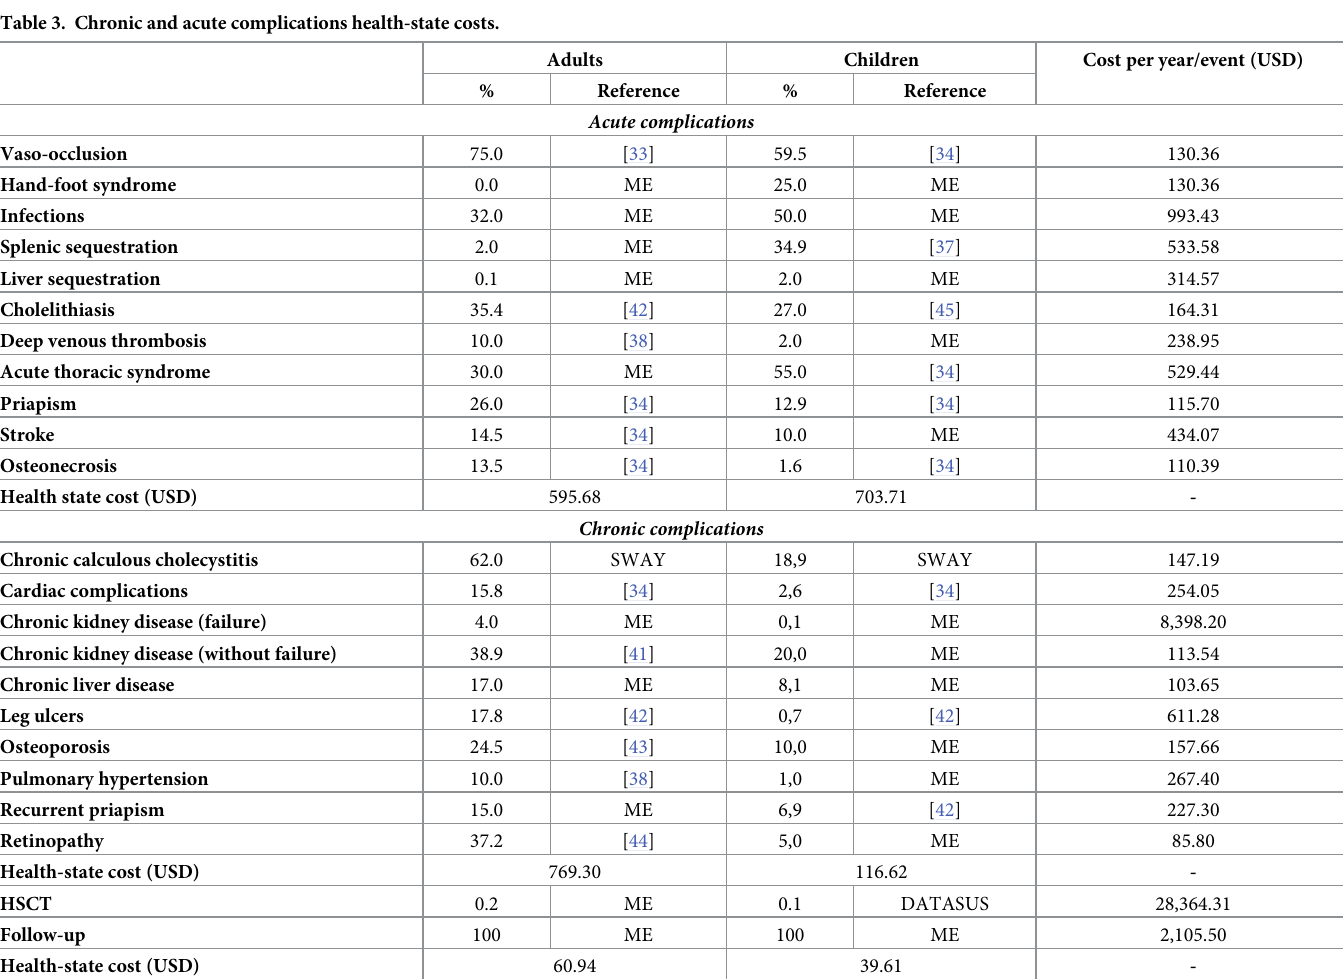
Table 3. Chronic and acute complications health-state